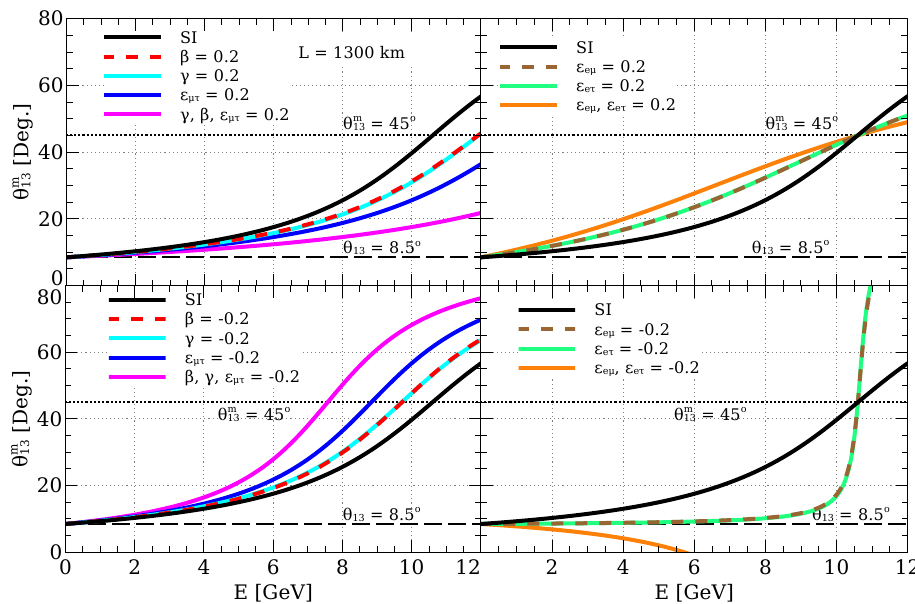
(given in eq. (4.2)) with energy in presence of SI and NSI in matter. The Figure 4 . Evolution of θ m 13 solid black curve in each panel shows the SI case while the other curves correspond to the variation in the presence of SI+NSI. In the top (bottom) row, the NSI have been considered with a benchmark value of 0.2 ( − 0 . 2 ). The left column depicts the presence of NSI parameters in (2,3) block while the right column shows the effect of ε and ε . We have used L = 1300 km and assumed NMO in the eµ eτ plot. Values of oscillation parameters in vacuum are given in table 2 with θ = 45 ◦ 23